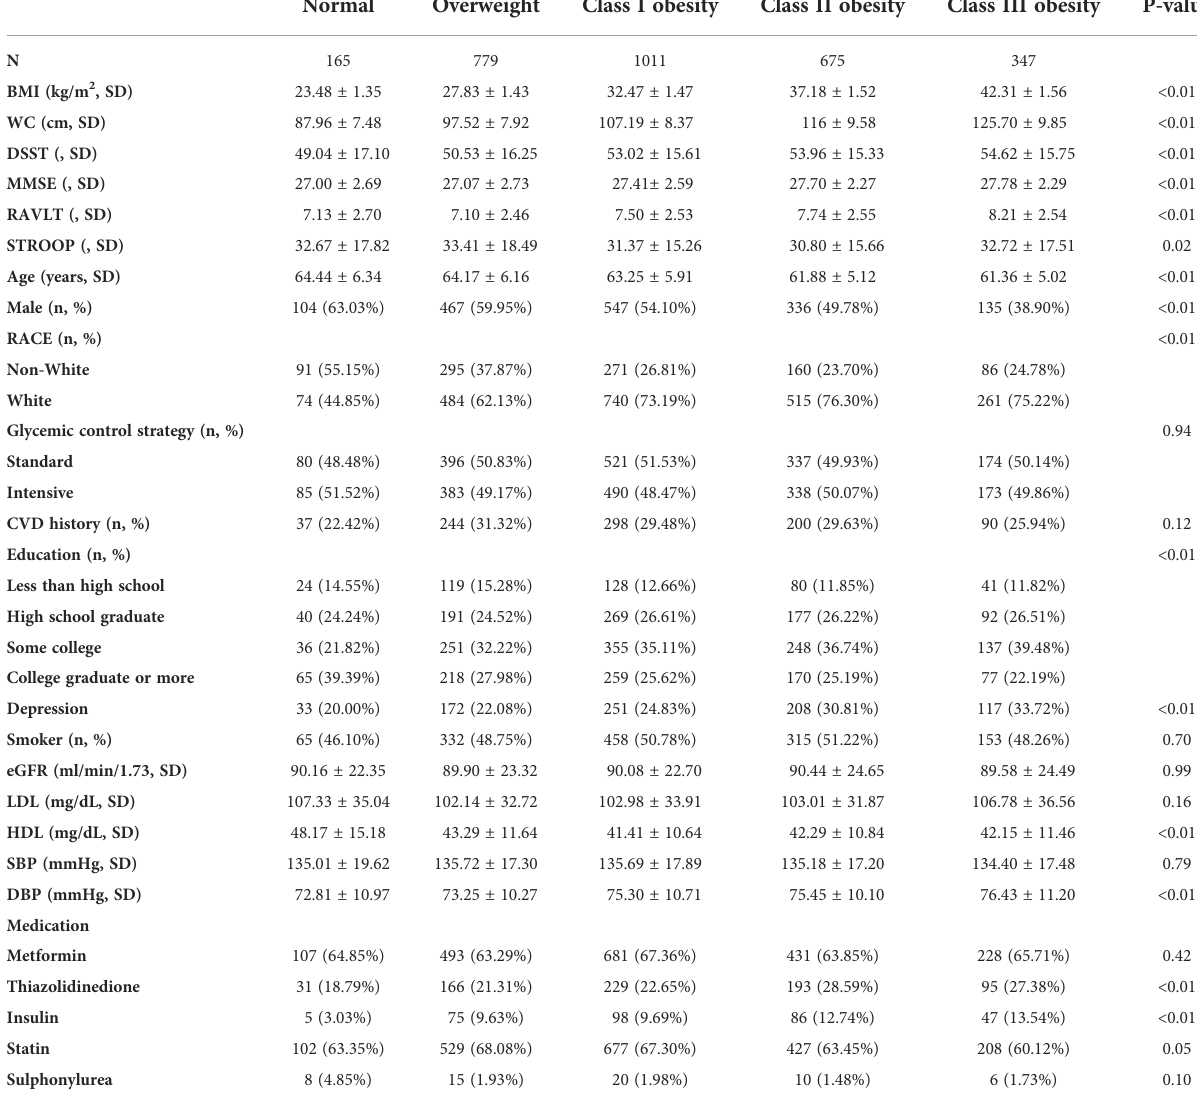
TABLE 1 Baseline demographic, clinical, and laboratory examination characteristics by BMI category.